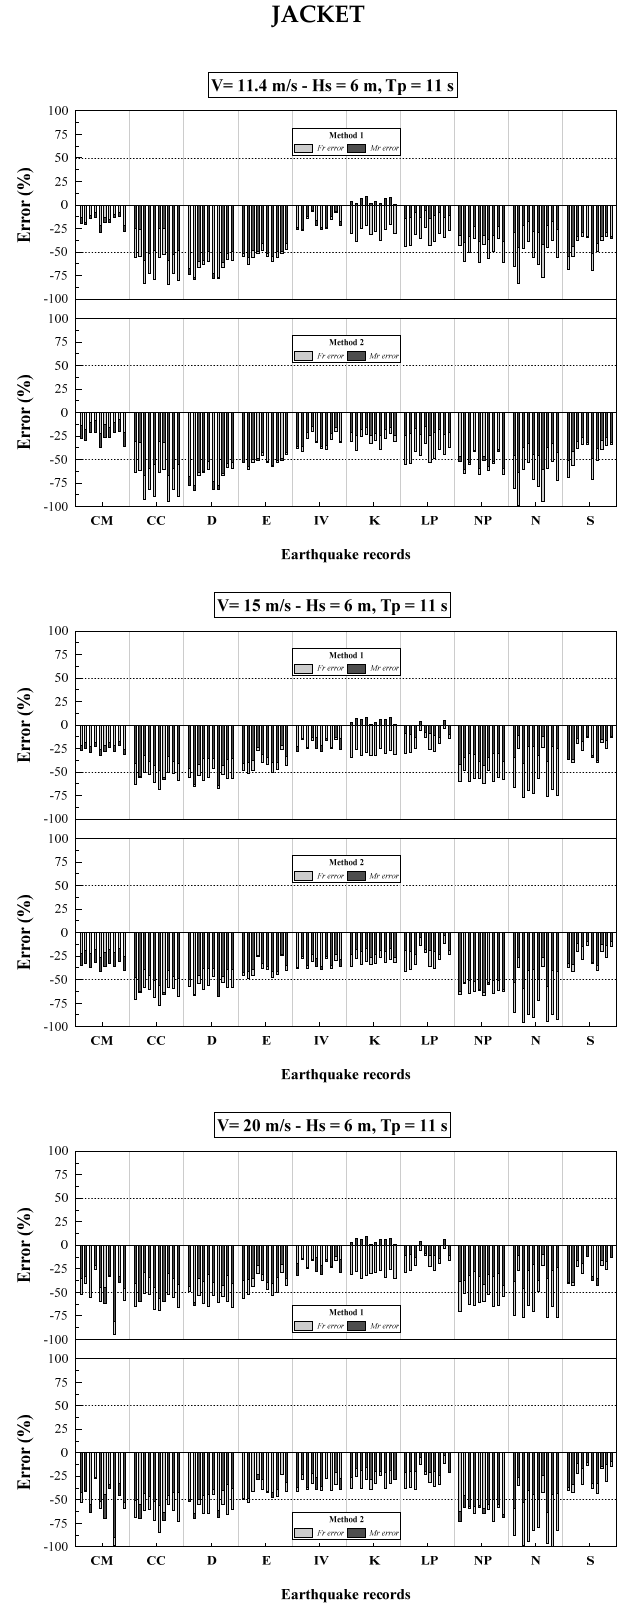
Figure 5. Jacket: Tower base errors (18) and (19) obtained by Methods 1 ‐ 2 for sea state parameters H s = 6 m, T p = 11 s, all wind velocities and earthquake records listed in Table 3.